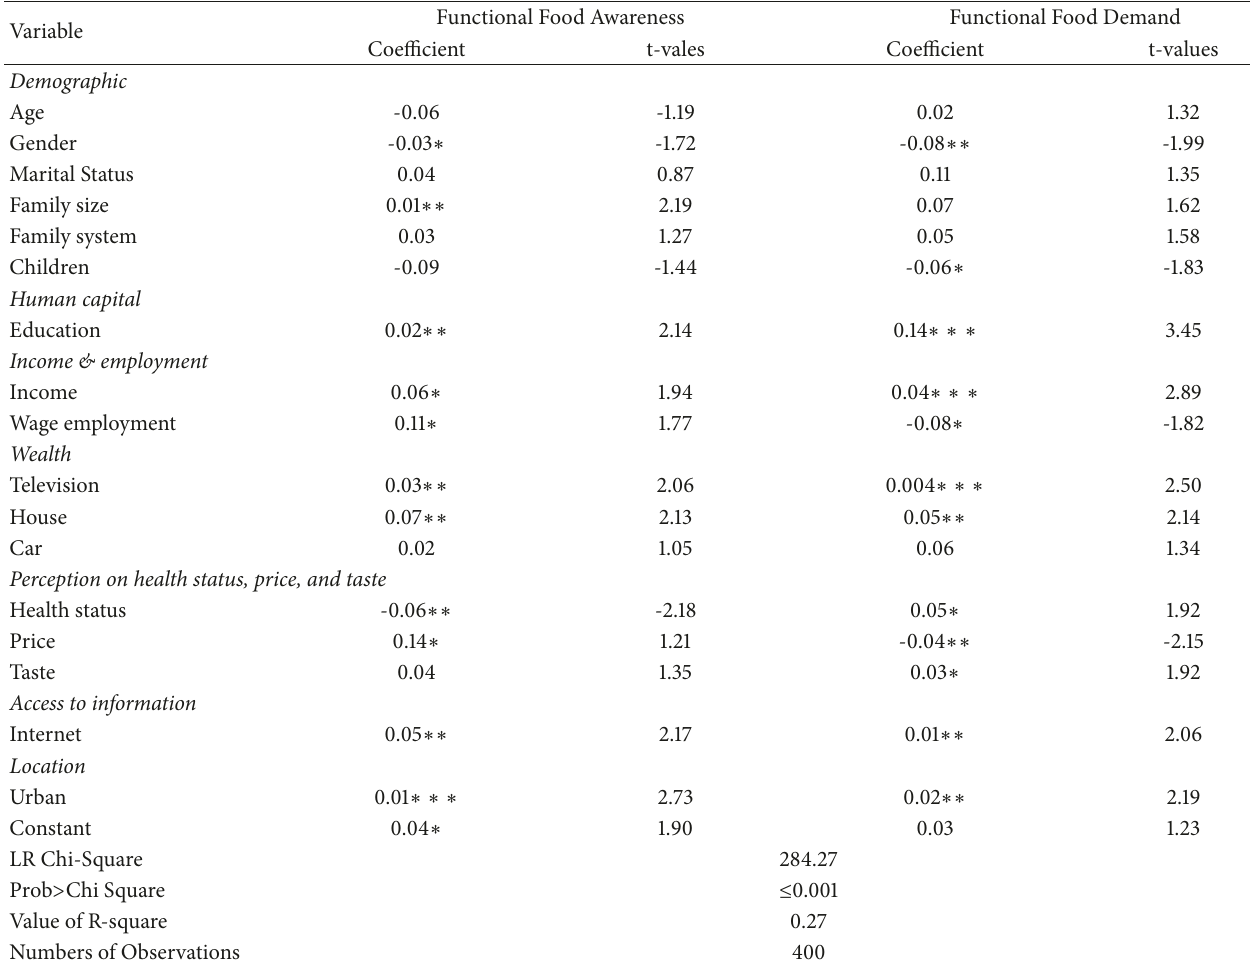
Table 3: Determinants of functional foods awareness and demand (Bivariate probit